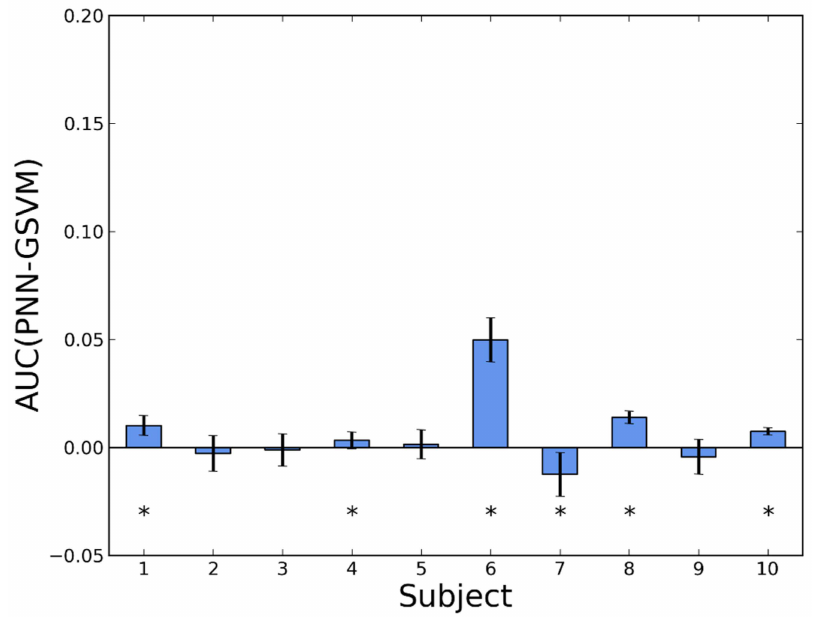
Figure 5. Difference in AUC between a personalized NN (PNN) and a generic SVM (GSVM). Whiskers represent standard deviations. Asterisks indicate p -values < 0.05 in a Wilcoxon test.